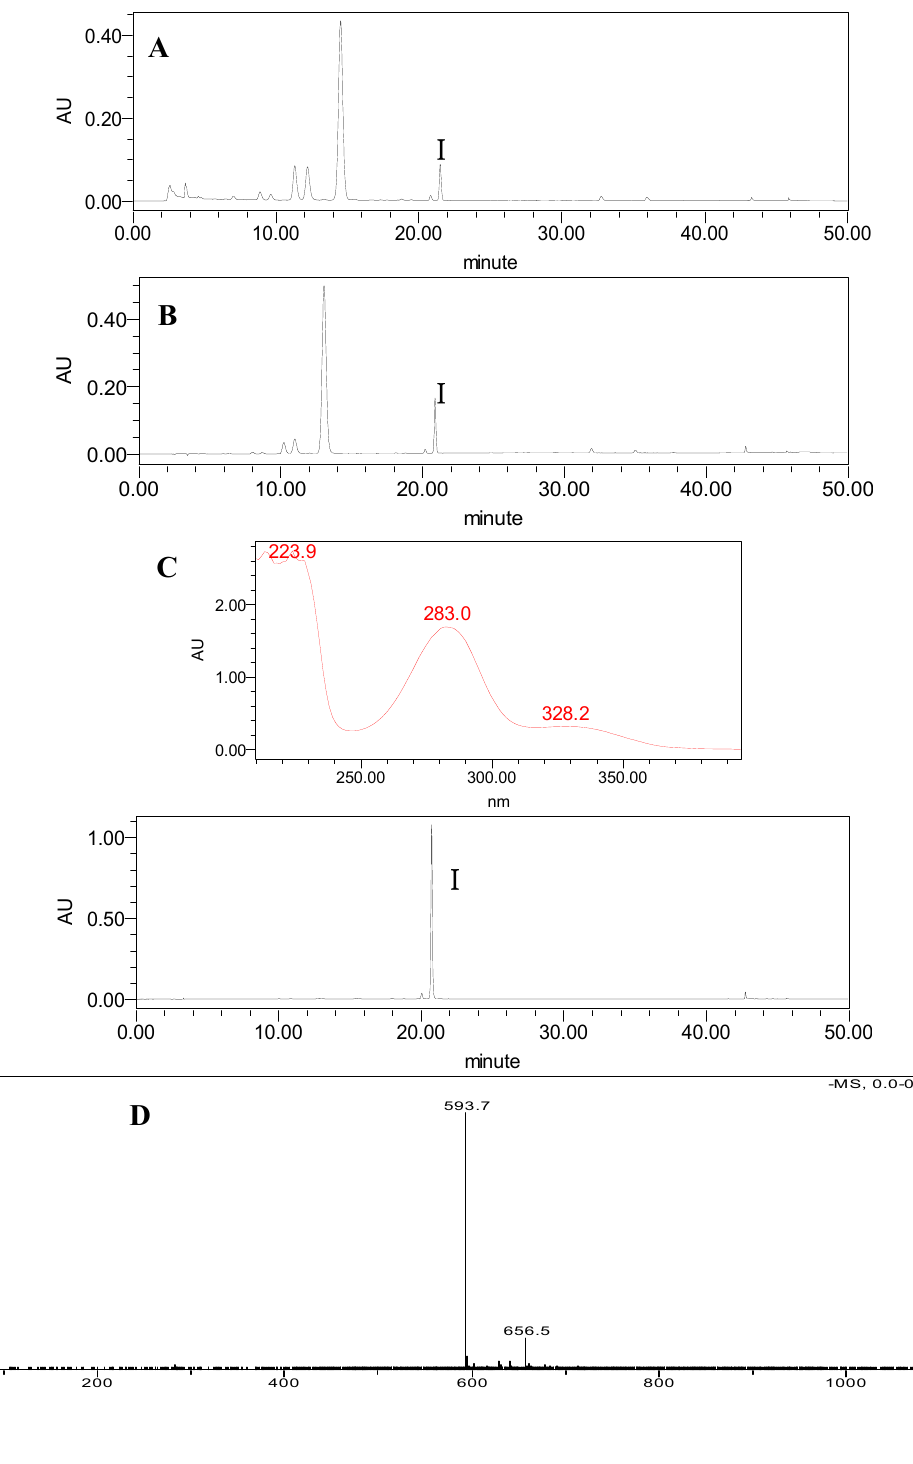
Figure 4. HPLC chromatogram and UV absorption spectrum of poncirin from crude extract before ( A ) and after ( B ) treatment with D101 resin and the purified product ( C ) from fraction I obtained by HSCCC. Peak I represents poncirin. ( D ) and ( E ), LC-MS chromatogram of HSCCC purified poncirin